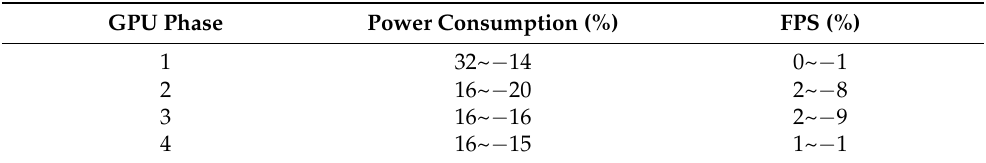
Table 2. Change rate of power consumption and FPS according to GPU phase when the GPU frequency is